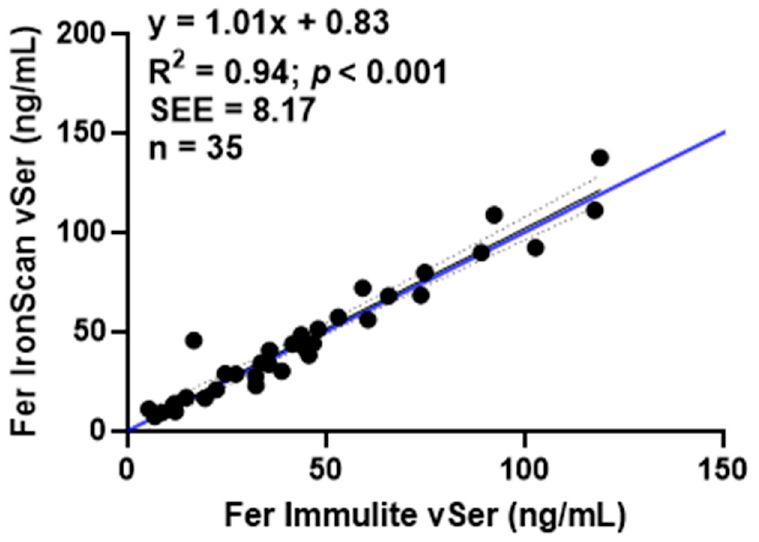
Figure 4. Comparison of ferritin (Fer) values from venous serum (vSer) samples using IronScan™ versus Immulite 2000 Xpi. Dashed lines represent 95% confidence intervals around the slope. Blue line represents the line of identity. Standard error of the estimate, SEE. Table 3. Identification of iron deficiency ( n = 44) 1